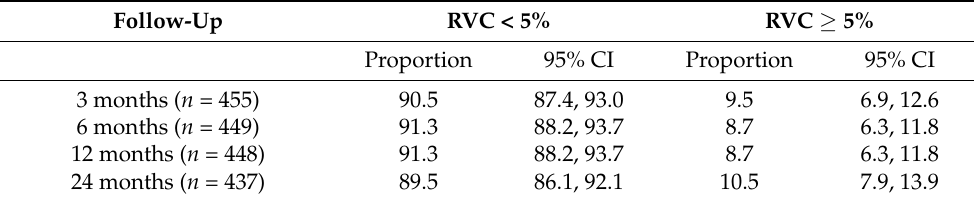
Table 2. RVC development over time of all patients based on RVC